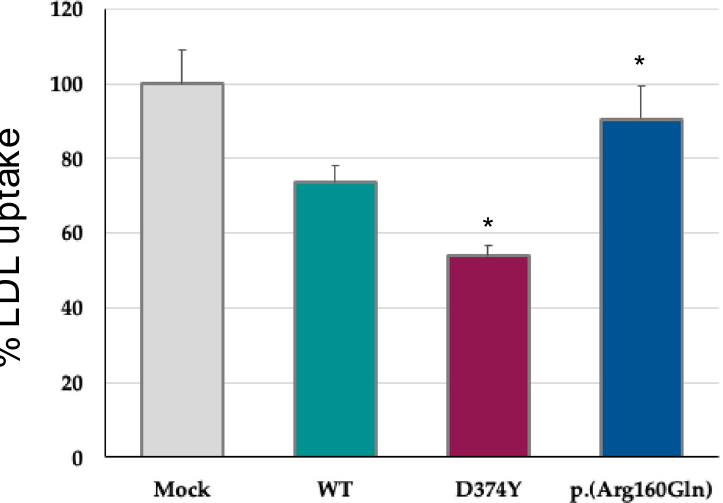
Figure 3 . Expression of the p.(Arg160Gln) PCSK9 variant increases LDL uptake compared to WT. Transiently transfected HEK293 cells with the different PCSK9 variants were incubated with FITC ‐ labelled LDL and lipoprotein uptake was measured by flow cytometry. Histograms represent the mean ± SD of three independent experiments. * p < 0.01 compared to WT. Mock corresponds to an empty plasmid. LDL uptake was normalised to the total amount of PKSC9 secreted to the culture medium 48 h post ‐ transfection.